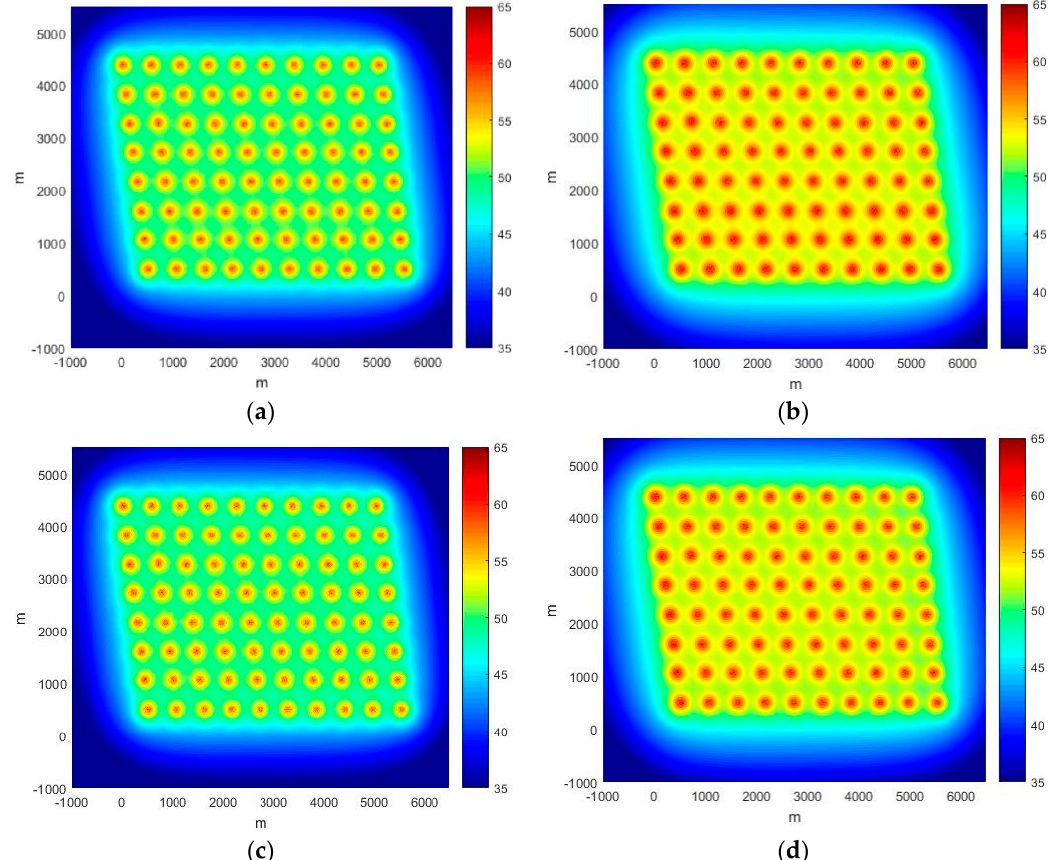
Figure 14. Sound pressure level of Horns Rev wind farm in different wind direction and speed. ( a ) 210°, 8 m/s; ( b ) 210°, 11 m/s; ( c ) 270°, 8 m/s; ( d ) 270°, 11 m/s.